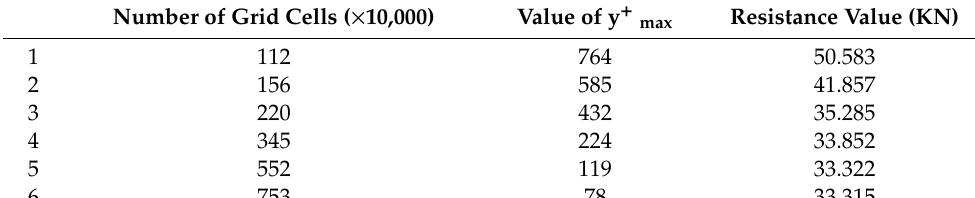
Table 3. y + and resistance calculation results of the six di ff erent meshes.